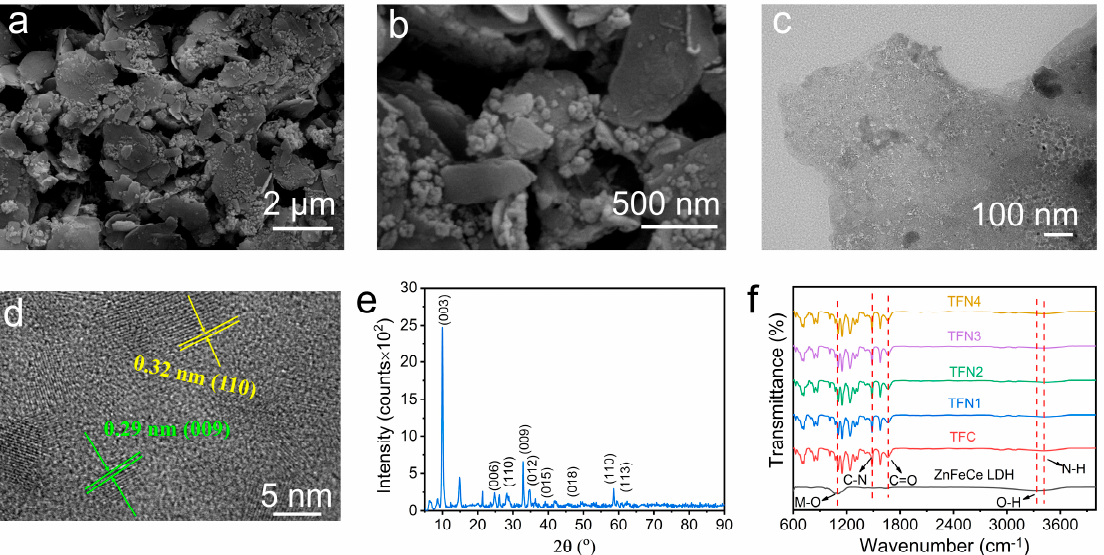
Figure 1. Scanning electron microscope (SEM) images ( a , b ) and high-resolution transmission electron microscopy HRTEM images ( c , d ) of the ZnFeCe LDH; X-ray powder diffraction (XRD) spectrum of ZnFeCe LDH ( e ); Fourier-transform infrared (FTIR) analysis of ZnFeCe LDH, TFC, and TFN membranes ( f ).